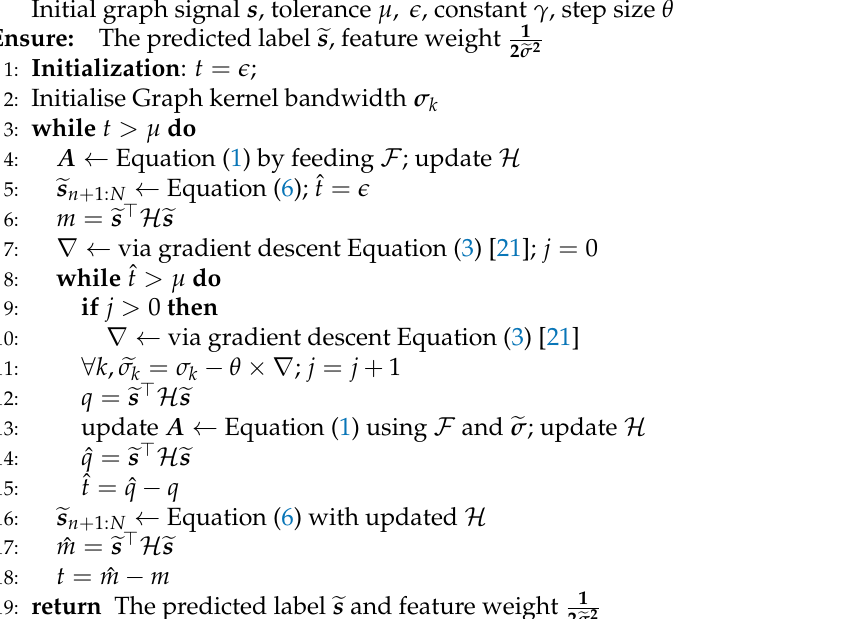
Algorithm 2 Alternative Graph-based Feature Weight Optimisation and Classification Constructed feature set